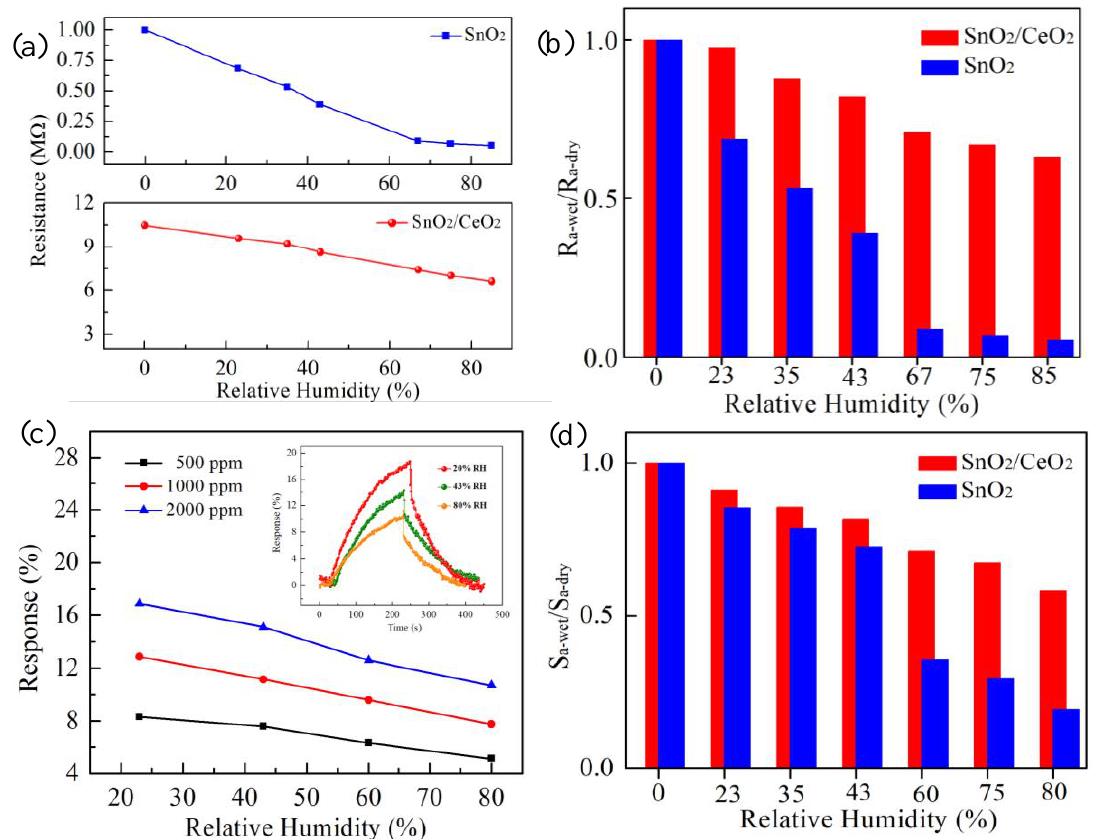
Figure 7. ( a ) The effect of relative humidity on the base resistance of the SnO 2 and SnO 2 /CeO 2 composite, and ( b ) the R a-wet /R a-dry values of the SnO 2 and SnO 2 /CeO 2 composite. ( c ) The effect of relative humidity on the response of the SnO 2 /CeO 2 composite, and ( d ) the S a-wet /S a-dry values of the SnO 2 /CeO 2 composite.